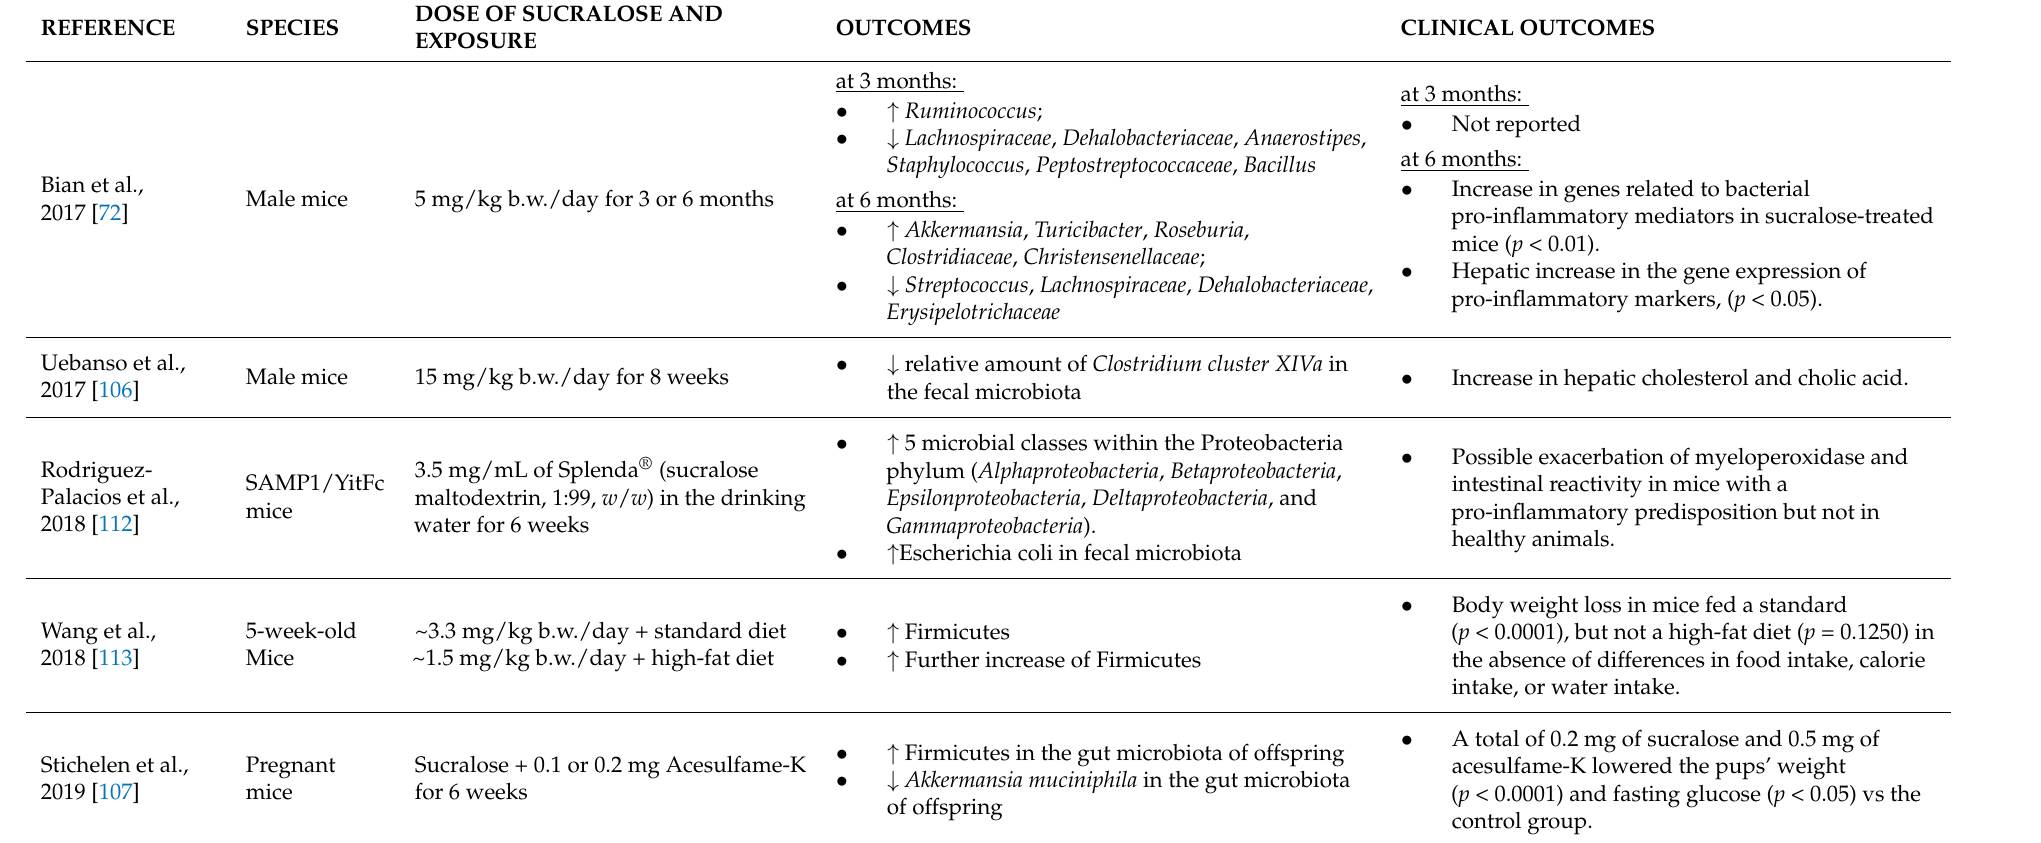
Table 4. Studies evaluating the effect of sucralose on the gut